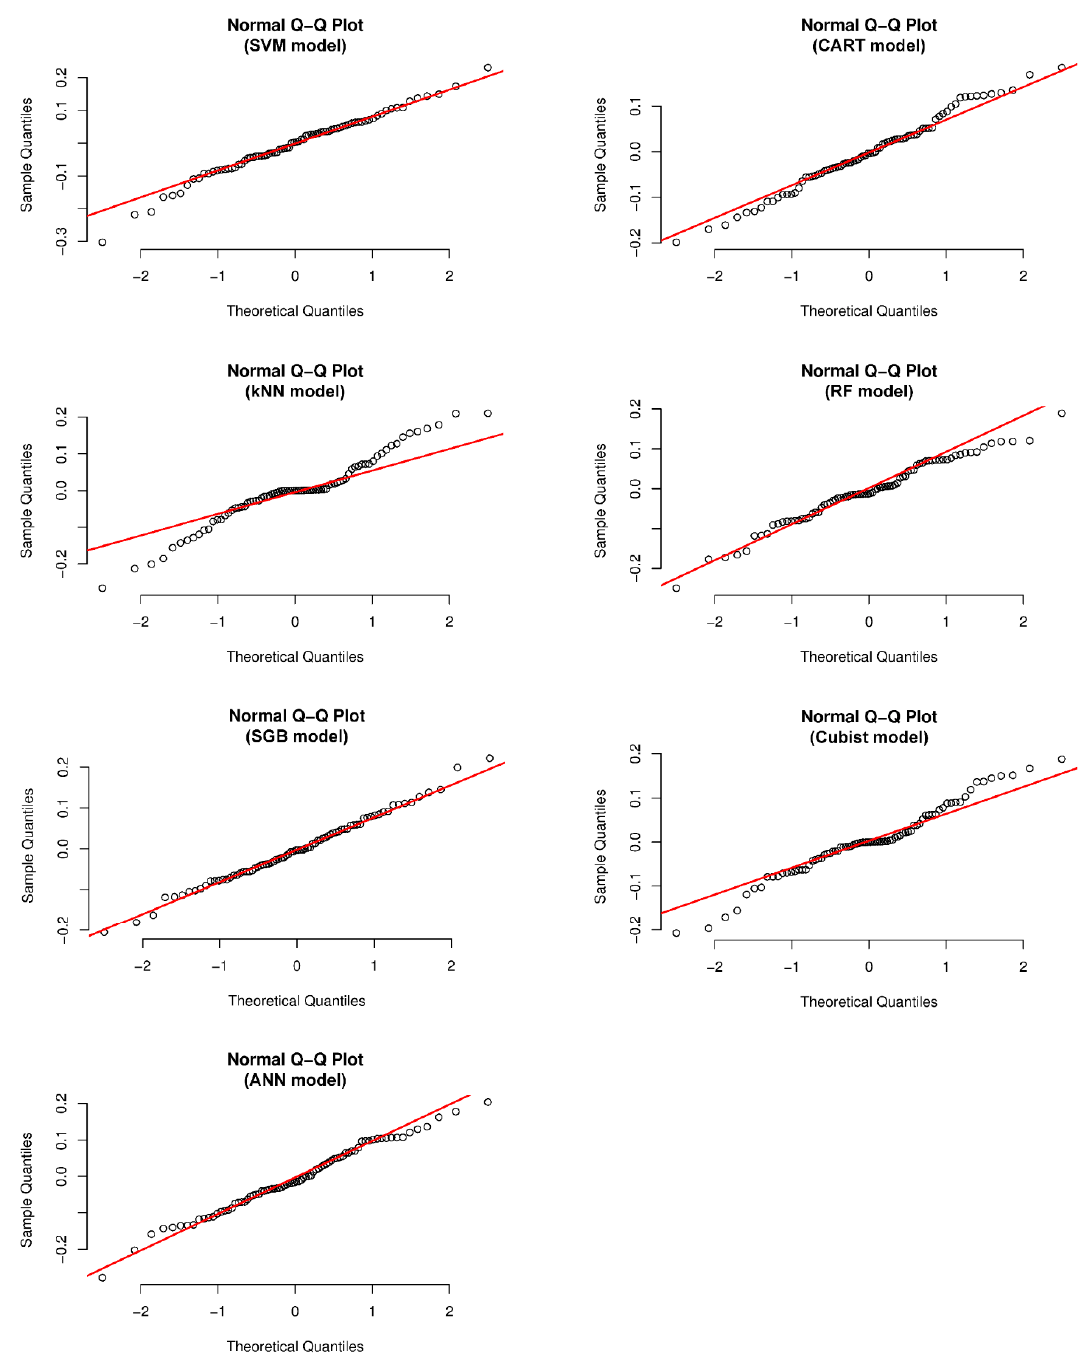
Figure 15. Normal probability plots of the residuals of the soft computing techniques